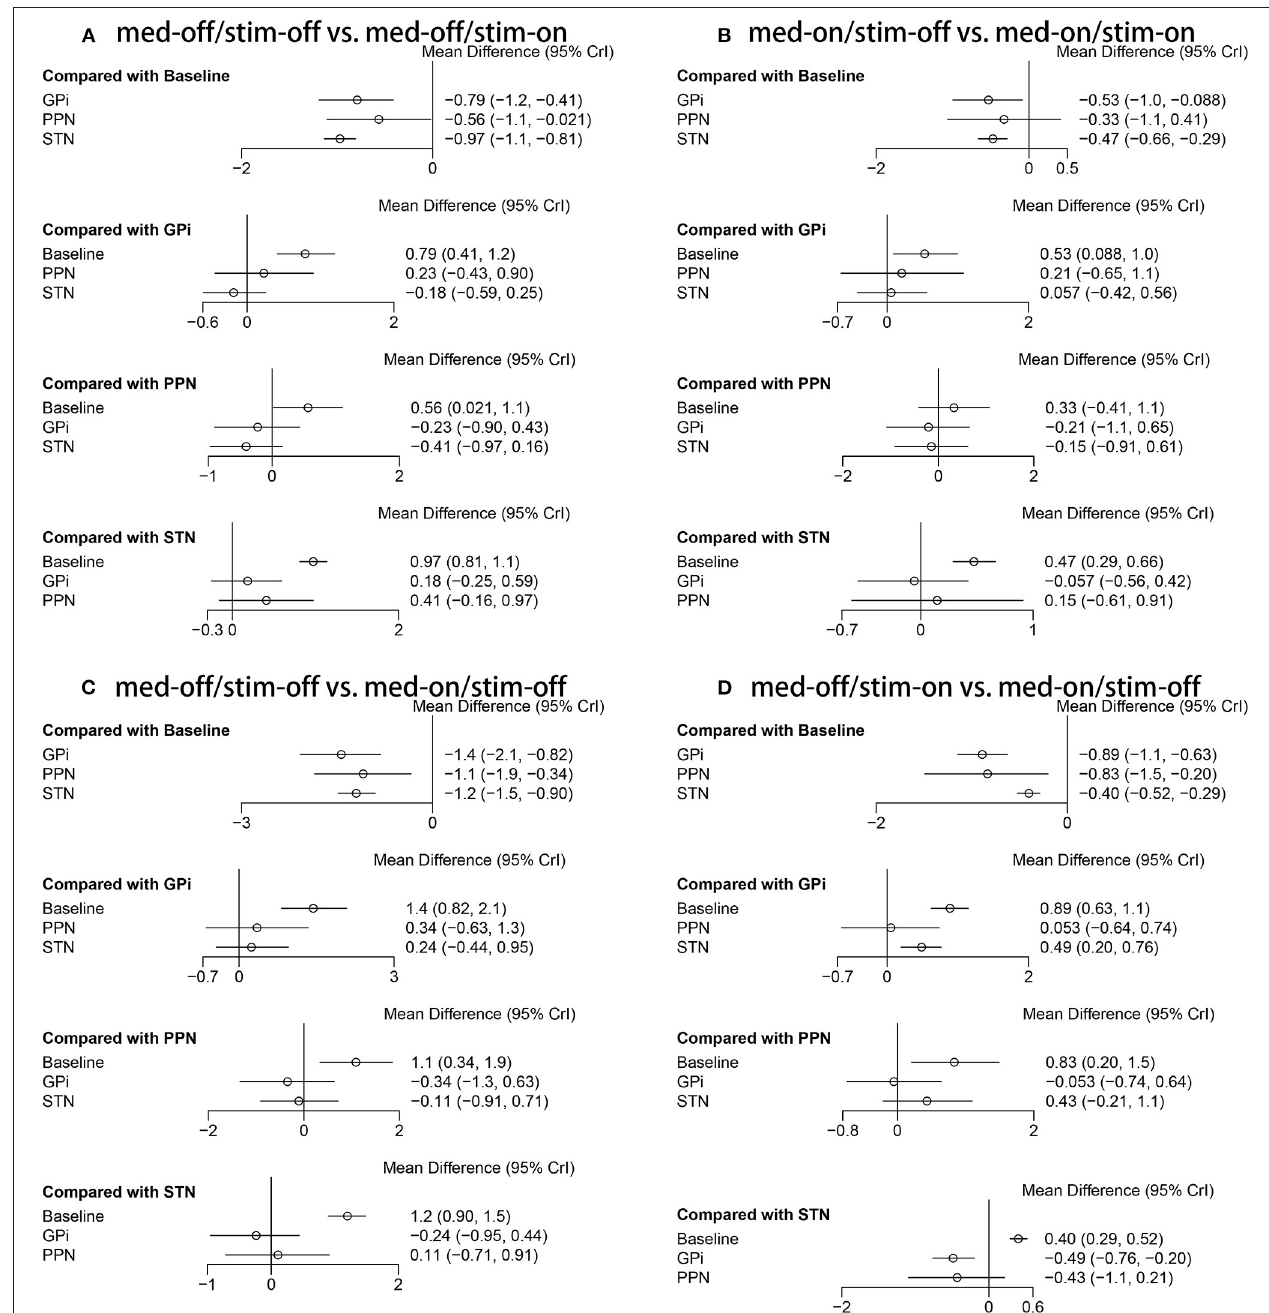
FIGURE 5 | Forest plot of mean difference of UPDRS-III (29 item, gait); (A) med-off/stim-off vs. med-off/stim-on, (B) med-on/stim-on vs. med-on/stim-on, (C) med-off/stim-off vs. med-on/stim-off, (D) med-off/stim-on vs.